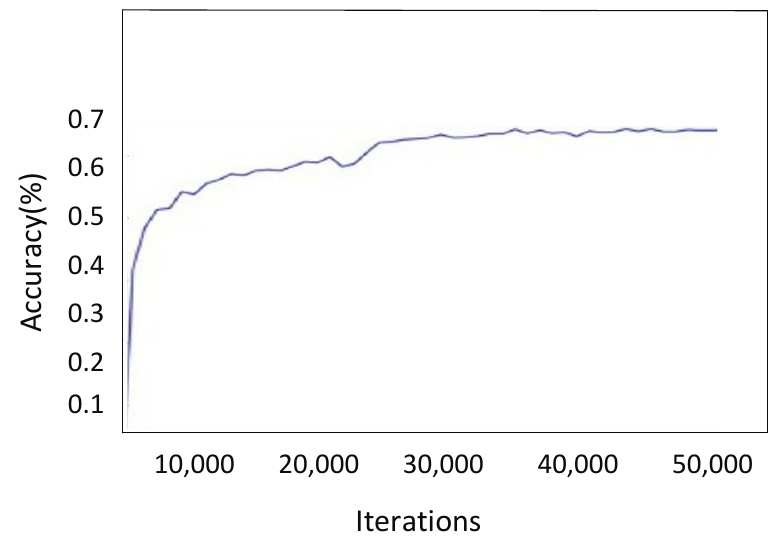
Figure 9. Illustration of increase in accuracy by increasing the number of